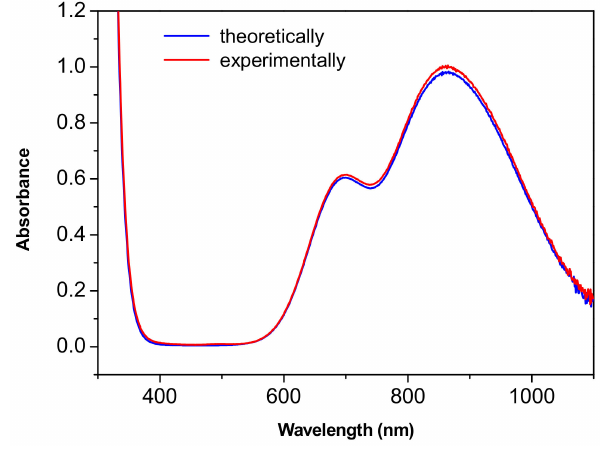
Figure 5. UV–vis spectra of CuCl 2 solution in the presence of Me 6 TREN in 2 mL of H 2 O. The red line represents the UV–vis spectrum of the disproportionation of CuCl (conditions: [CuCl]:[Me 6 TREN] = 1:1 in 2 mL H 2 O). The sample was diluted before analysis into degassed H 2 O.